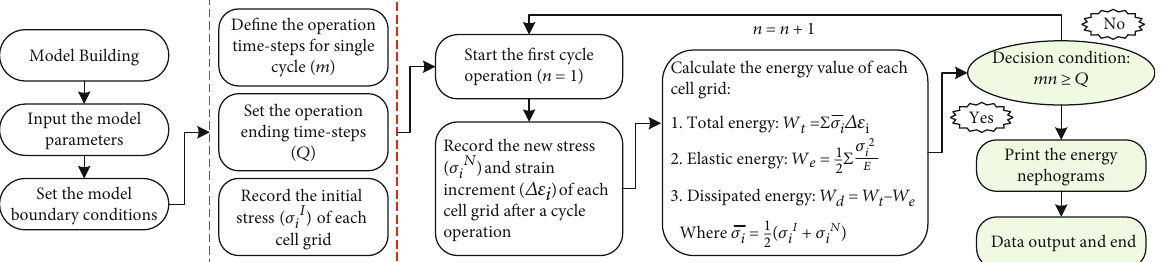
Figure 1: Flow chart of cell grid energy calculation in FLAC 3D .